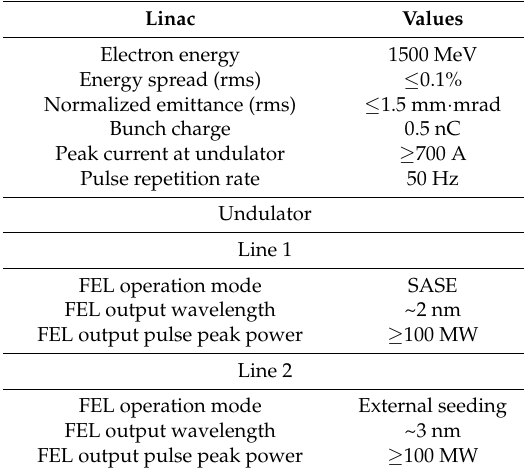
Table 4. Main parameters of the SXFEL-UF. Figure 11. Schematic layouts: SXFEL-TF ( upper ) and Shanghai soft X-ray Free-Electron Laser User Facility (SXFEL-UF) ( lower ).